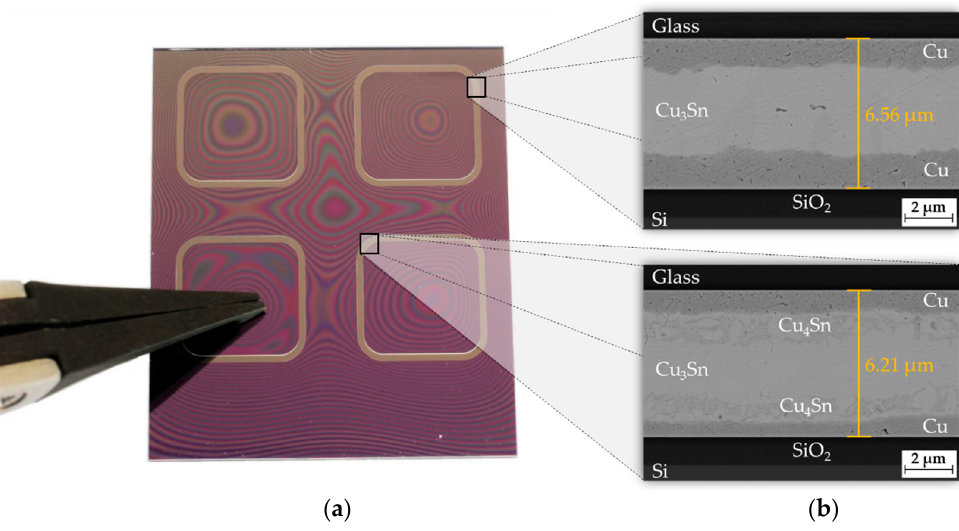
Figure 22. Inductive Cu-Sn SLID bonding for I 0 = 78.6 A and f 0 = 1.898 MHz: ( a ) Silicon-glass chip stack with Newton’s rings; ( b ) SEM images of the formed bond with the IMCs Cu 3 Sn and Cu 4 Sn.